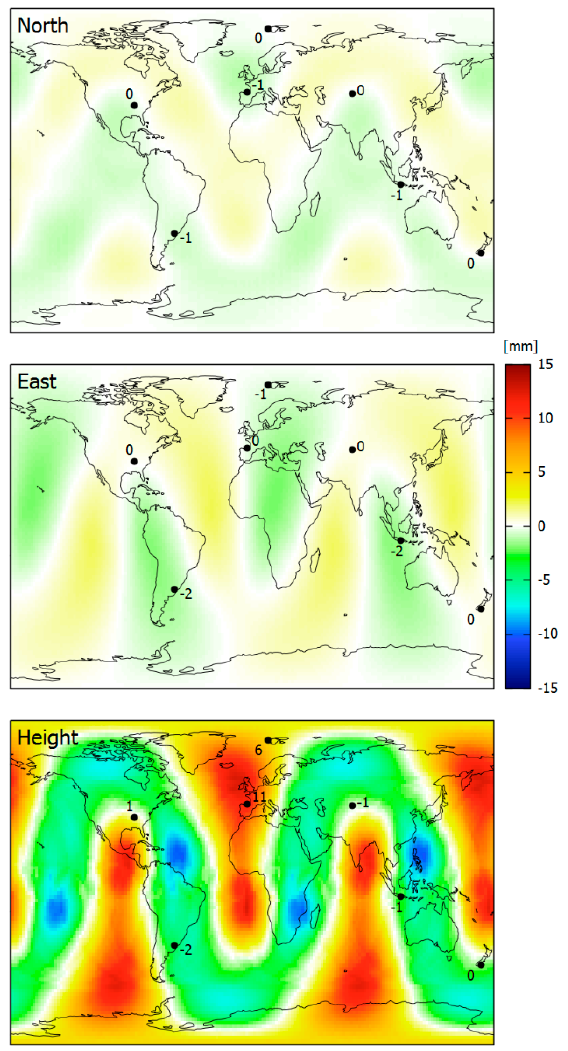
Figure 6. Coordinate errors of 24 h static positioning in early 2018 due to L2 quarter cycle biases: ionosphere-free linear combination with ambiguities being fixed, estimation of tropospheric zenith delays enabled, based on simulated stations in a 2° × 2° grid and on seven real stations.